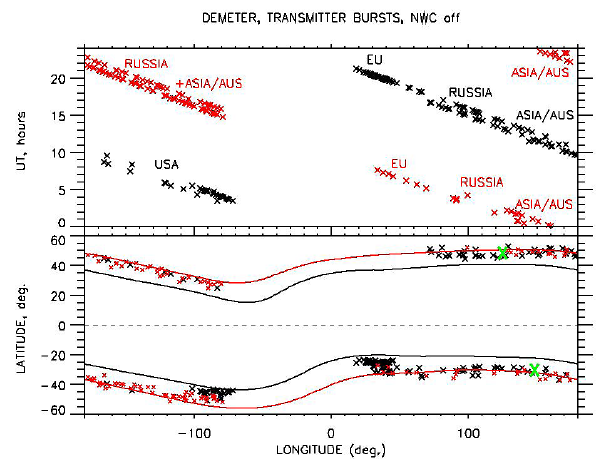
Fig. 9. UT–longitude (top) and latitude–longitude distribution of electron burst during the three months (July–August, September 2007) when the NWC transmitter is off. The red symbols indicate measurements made around 10:00 local time, while the black sym- bols are for 22:00 local time. The red and black curves in the bot- tom panel show respectively the L = 2 and L = 1 . 5 locations in the Northern and Southern hemispheres. The green crosses correspond to the measurement of electron bursts presented in Sideropoulos et al. (2011) as due to a precursor to an earthquake. The regions where the bursts are produced are indicated in the top panel.